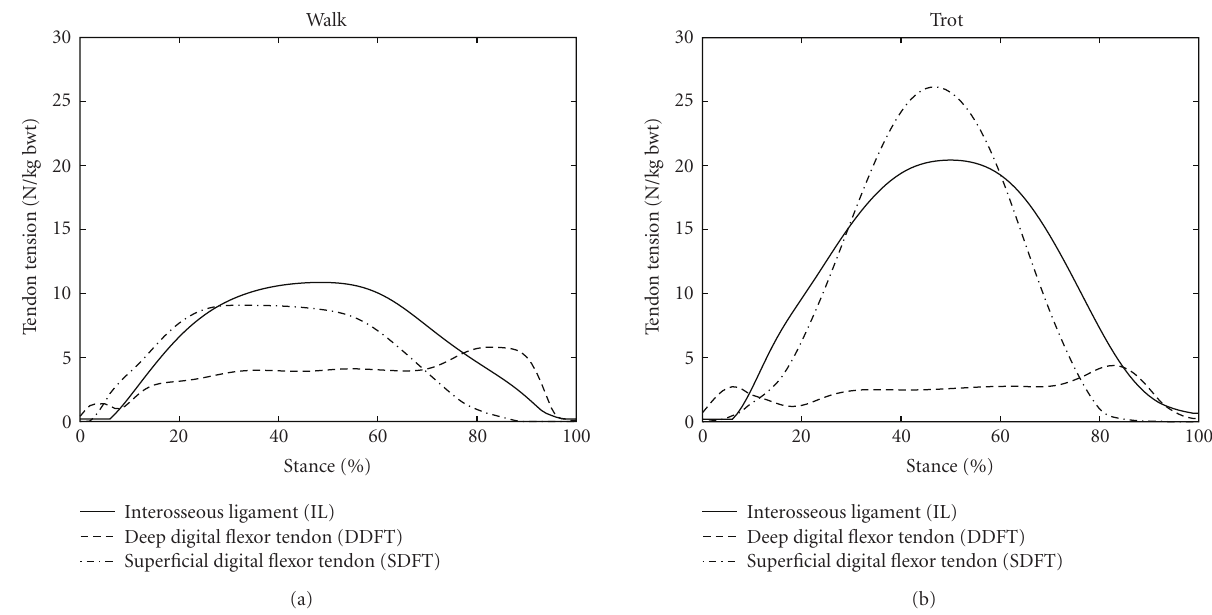
Figure 5: Mean tendon tensions in the DDFT, SDFT, and IL for walking and trotting during the stance phase of the stride. The stance phase of the stride was the time during which the vertical component of the ground reaction force was greater than 50 N. 0% of stride was the time of first hoof-ground contact, while 100% of stride was the time of last hoof-ground